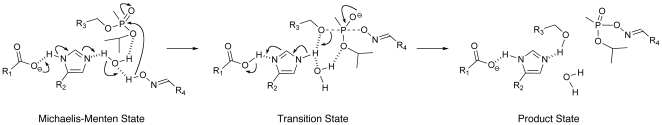
Proposed reactivation mechanism of sarinnonaged-mAChE by HI-6.Dashed lines represent the bond between the phosphorous atom and the attacking or leaving atom. Hashed lines show hydrogen bonds.